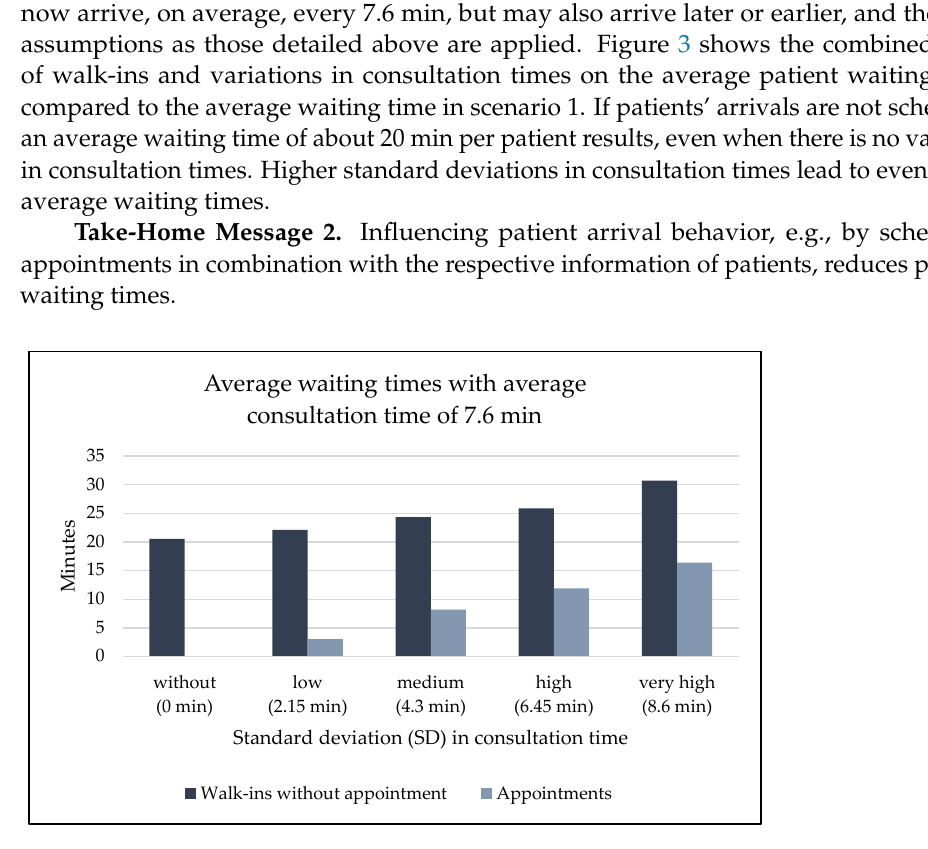
Figure 3. Comparison of patient waiting times in scenario 1 (‘fixed appointments’) and scenario 2 (‘walk - ins’) for different standard deviations in consultation time.